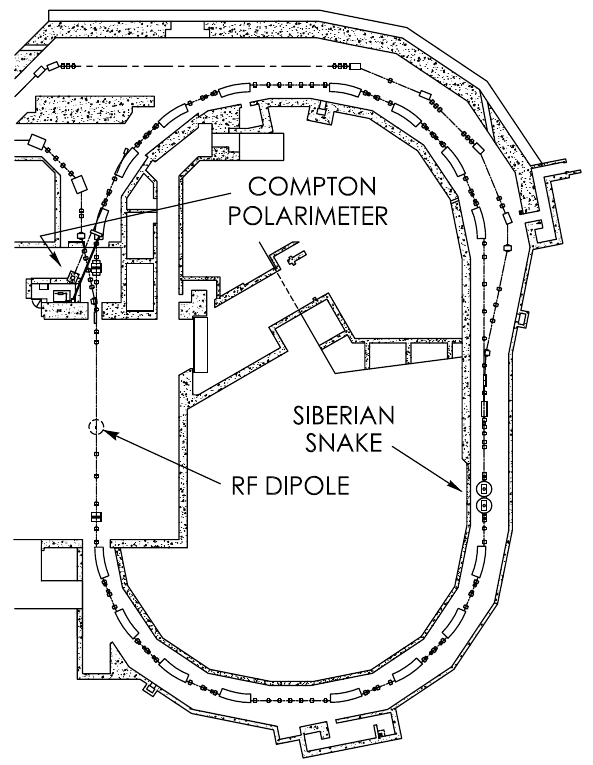
FIG. 1. The MIT-Bates storage ring, showing the rf dipole, the polarimeter, and the Siberian snake.